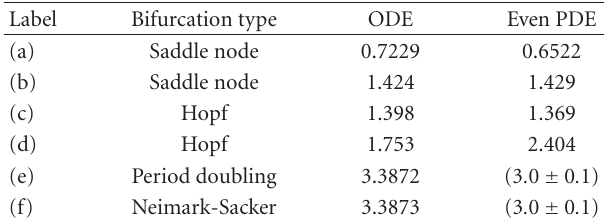
Table 1: The values of g 0 associated with each bifurcation in the ODE and PDE. The labels correspond to the bifurcations of the ODE in Figure 13. Values in parenthesis are estimated from the same